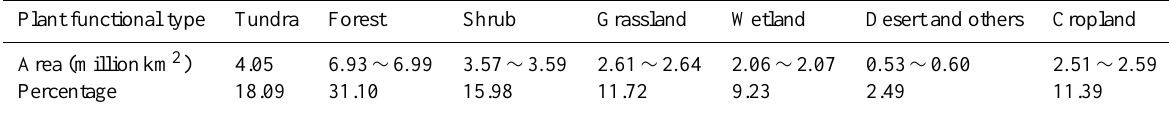
Table 3. Land area of the major biomes in North America. Plant functional type Tundra Forest Shrub Grassland Wetland Desert and others Cropland Area (millionkm 2 )